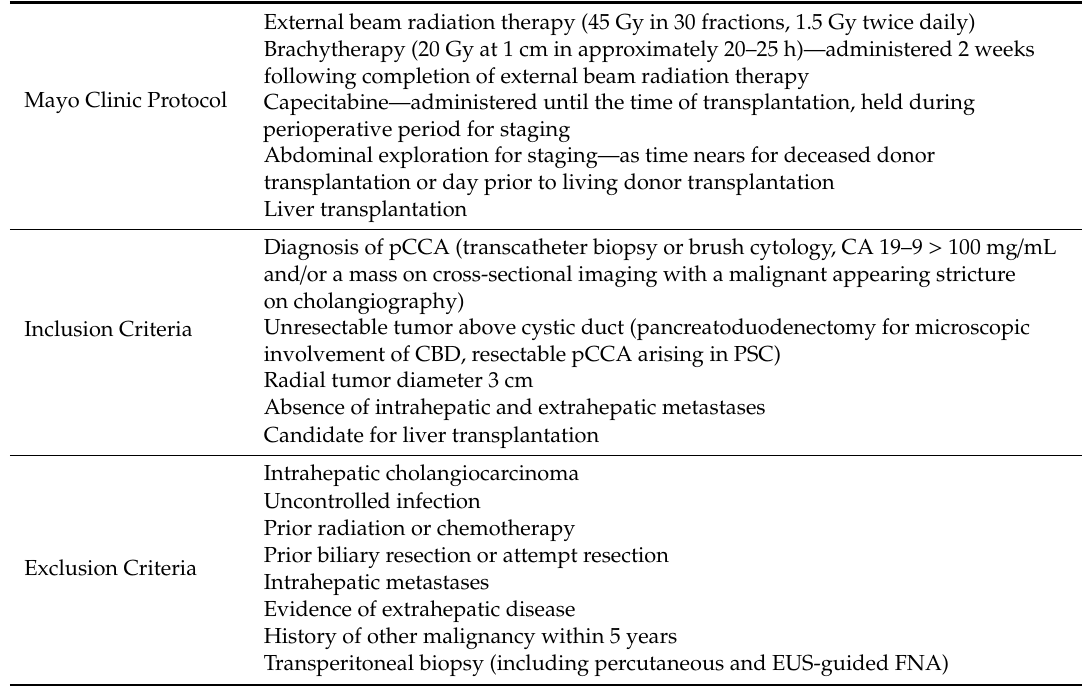
Table 1. Mayo Clinic